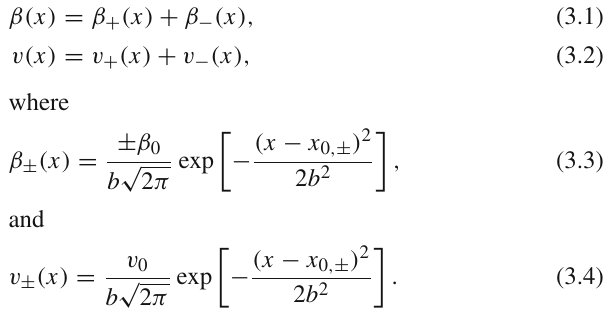
x 0 , + = 4 . 5 × 10 − 4 . The large dashed line is for x 0 , − = 1 . 45 × 10 − 3 = 5 b + x 0 , + , the medium dashed line is for x 0 , − = 6 . 5 × 10 − 4 = b + x 0 , + , ( 0 ) = 0, η ( 0 ) = η ( 0 ) = η ( 0 ) = 0, the dotted line is for x 0 , − = 4 . 7 × 10 − 4 = 0 . 1 b + x 0 , + , and the e R e L Y B = − β = 5 × 10 − 4 , and 0 , + 0 , −